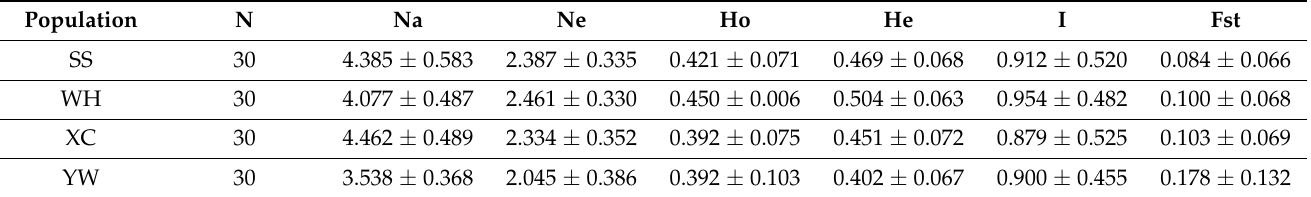
Table 6. Statistical values of genetic diversity of 13 SSR sites in four H. molitrix populations.